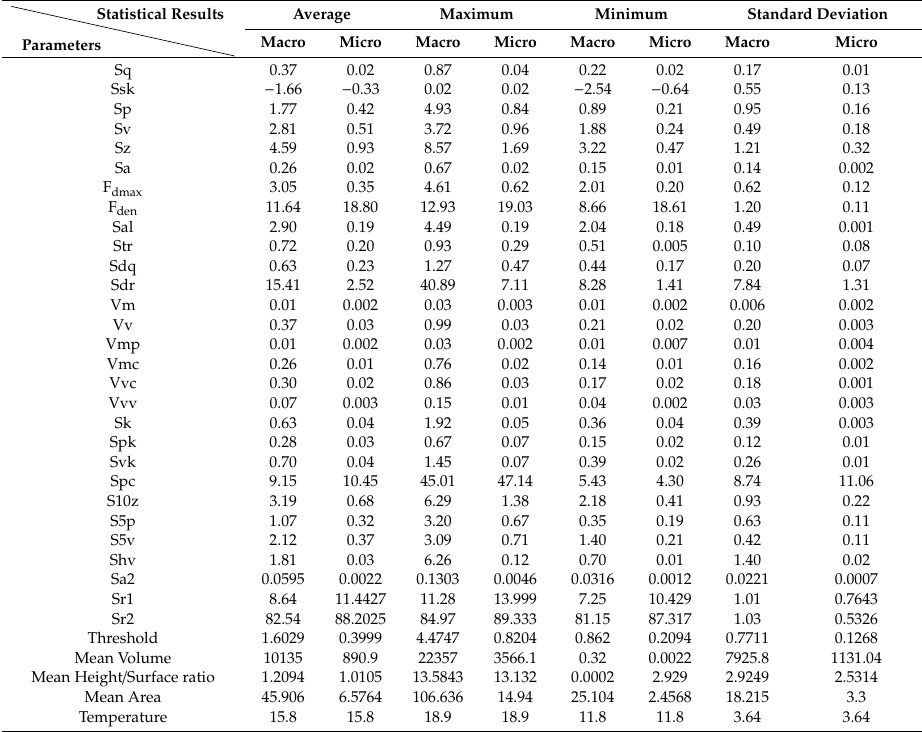
Table 4. Statistics of pavement 3D texture